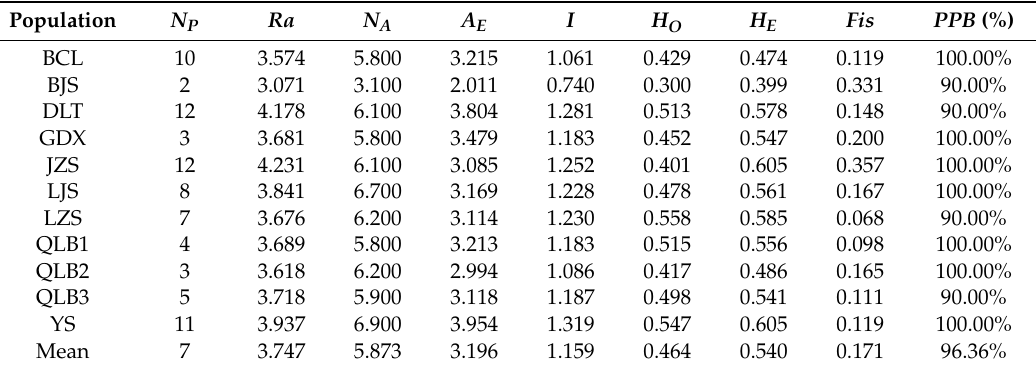
Table 2. Genetic diversity of populations in R. rex subsp.